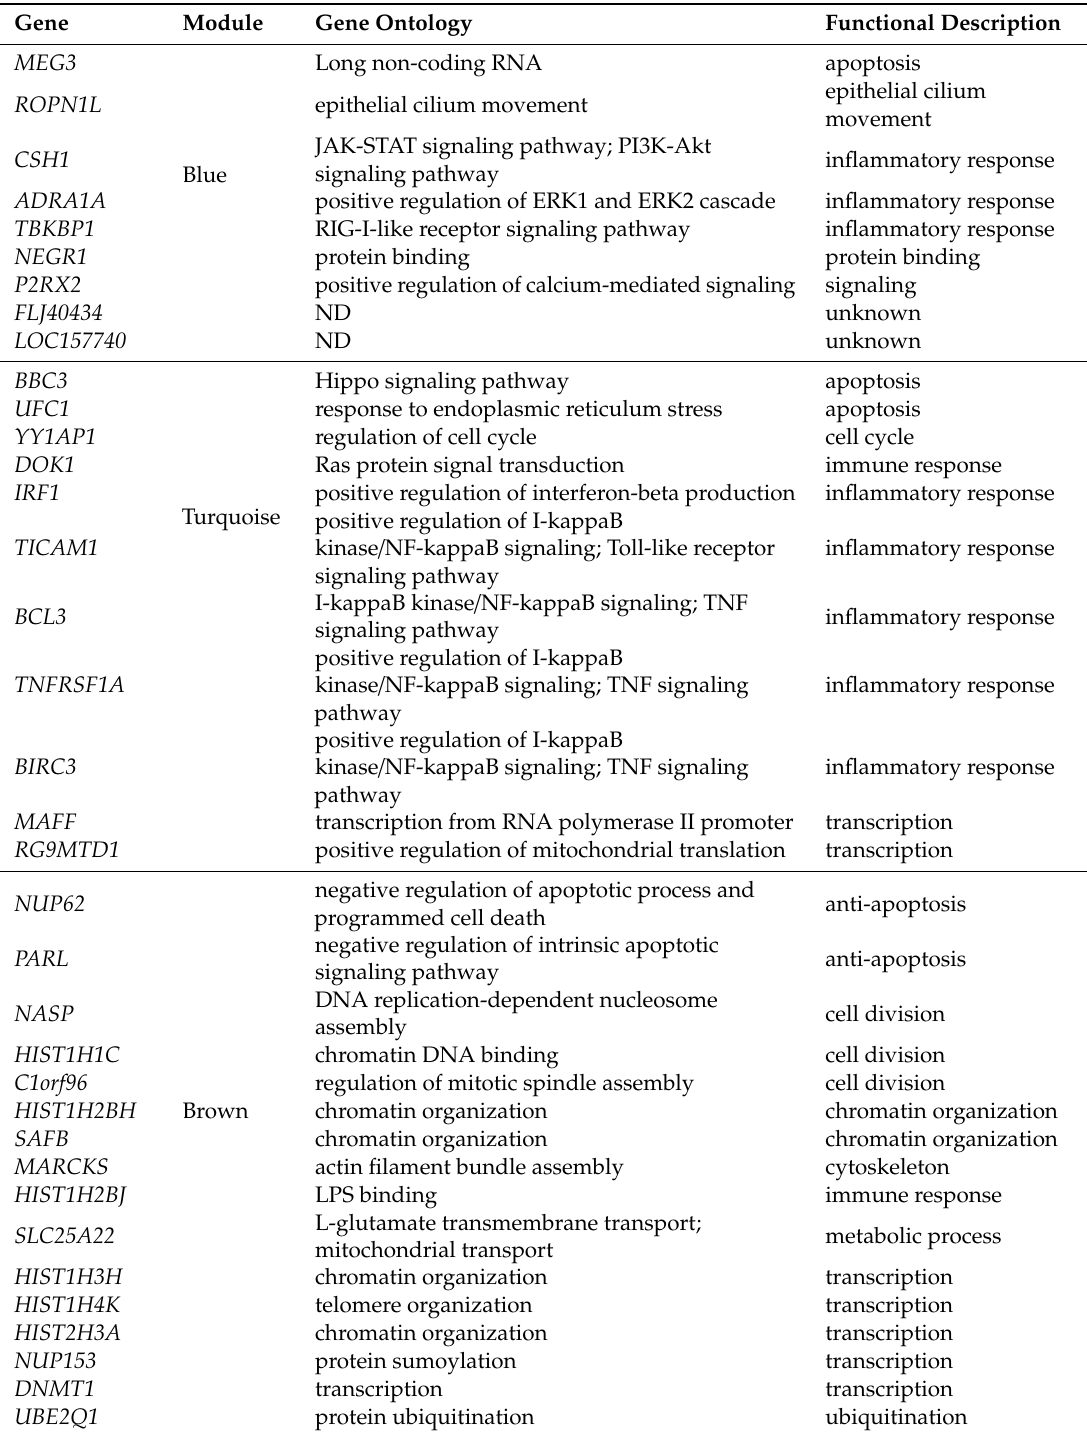
Table 1. Hubs in Caco-2 / EH41